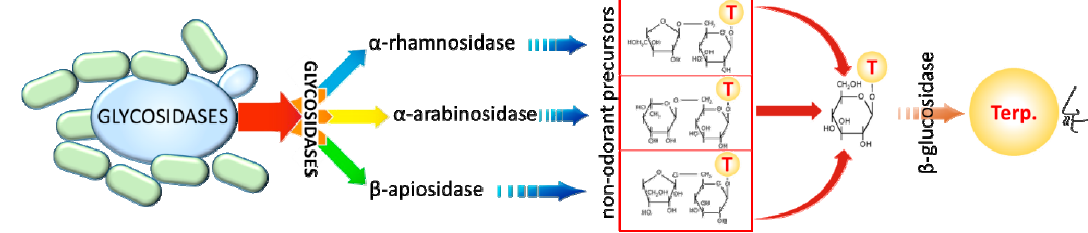
Figure 6. Release of terpenes from their correspondent non-odorant precursors by glycosidases of microbial origin.